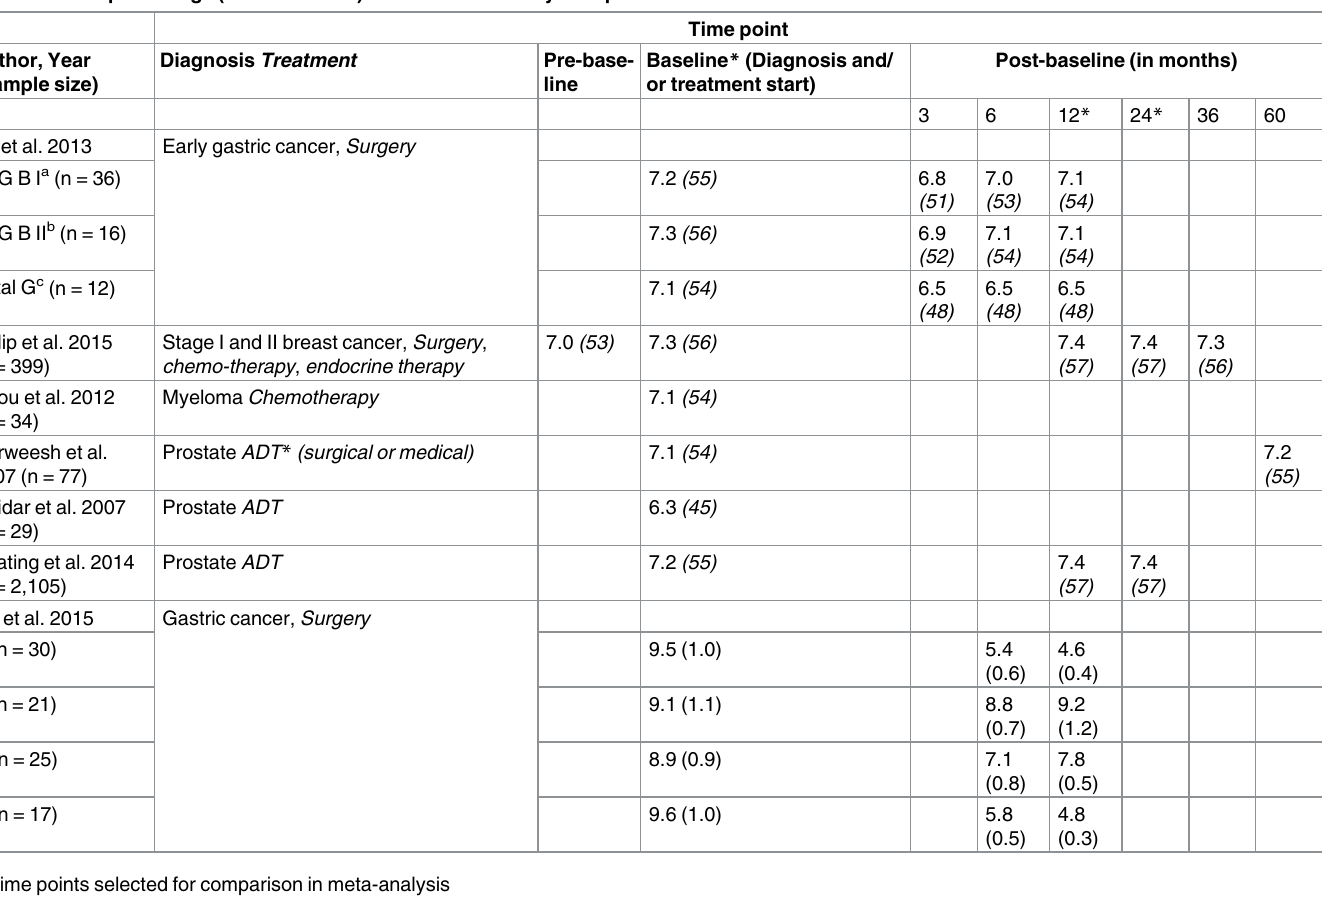
Table 3. Mean percentage (and mmol/mol) HbA1c across study time points.